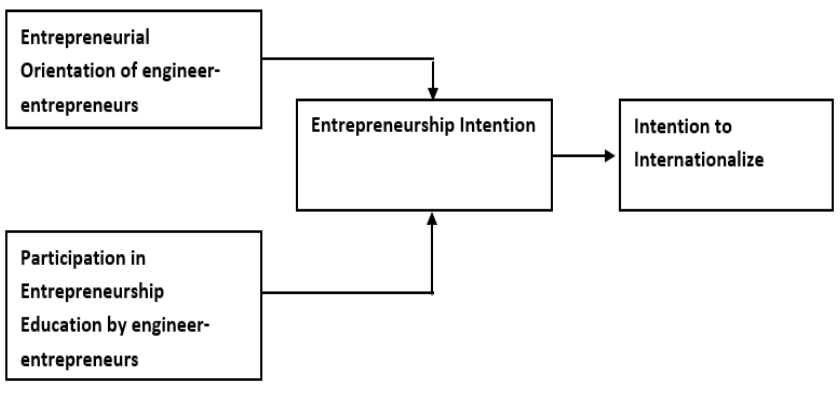
Figure 01: Conceptual Framework developed based on literature review